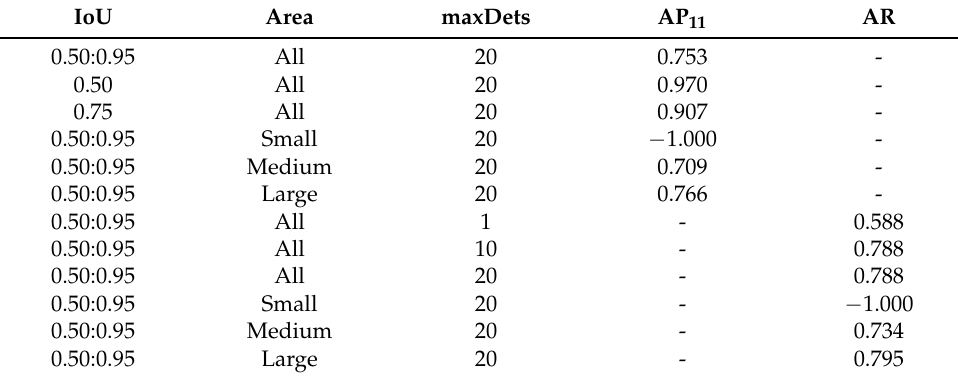
Table 4. Results on YOLO-GD using COCO API.